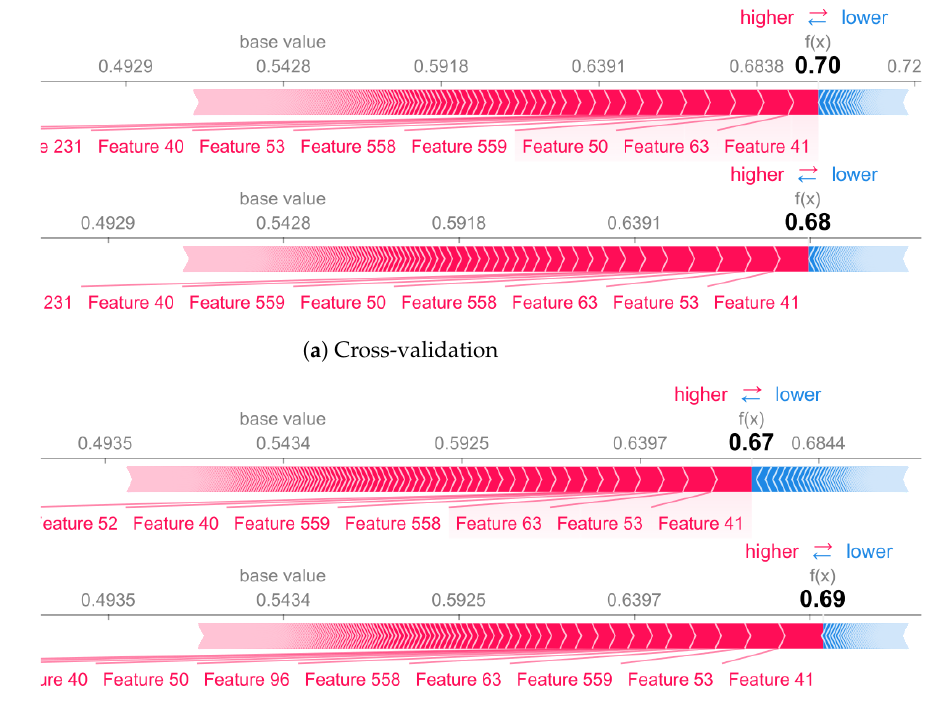
Figure 11. Standing activity for cross-validation ( a ) and holdout ( b ) validation methodology.